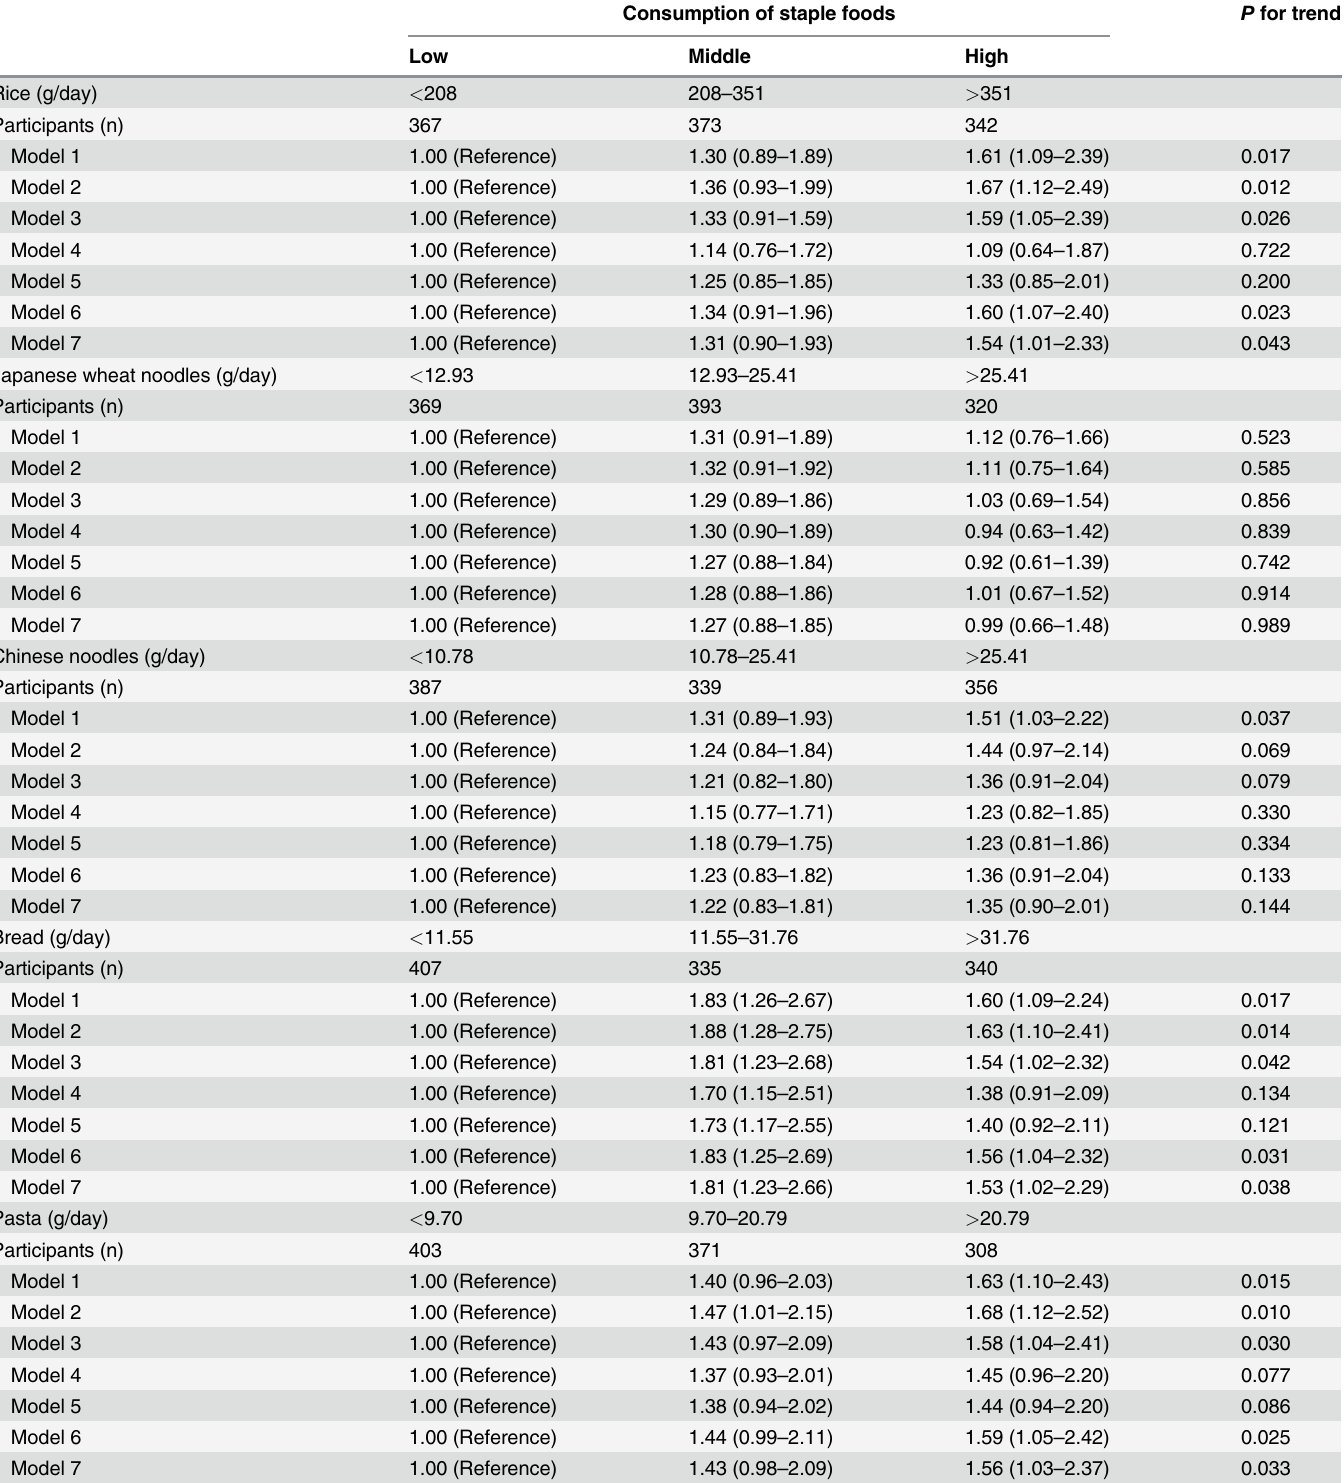
Table 3. Odds ratios (95% con fi dence interval) of IBS prevalence in staple foods consumption.